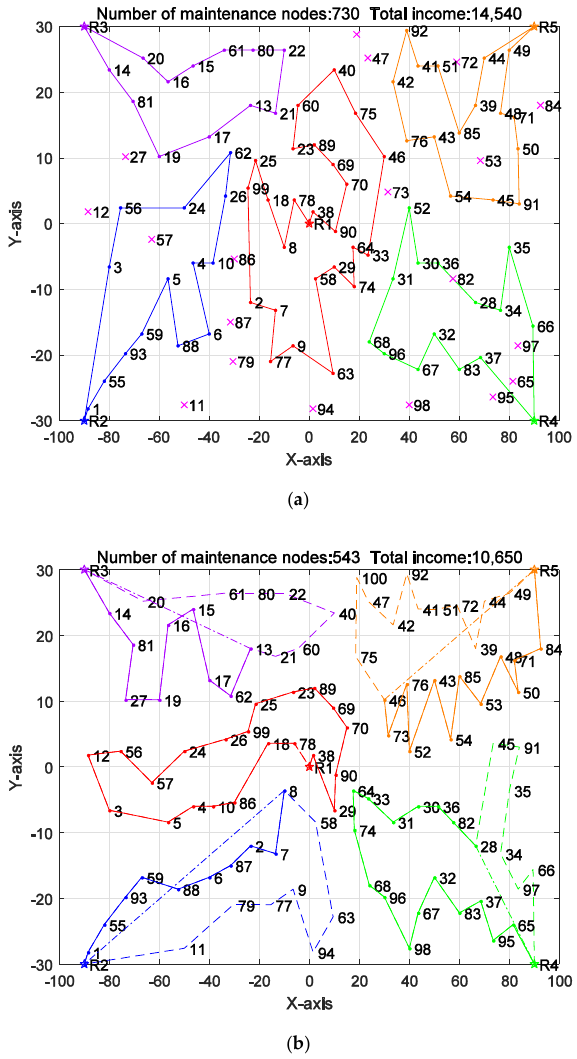
Figure 5. Comparison of maintenance routes when the space-robot cluster energy is 7000. ( a ) Optimal- path model; ( b ) shortest-path